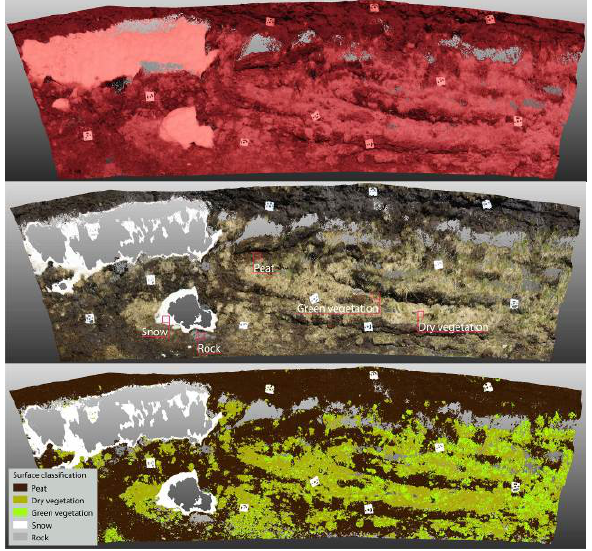
Figure 7. Image based point cloud (left) and TLS point cloud (right) of Zirbenwald rockfall.